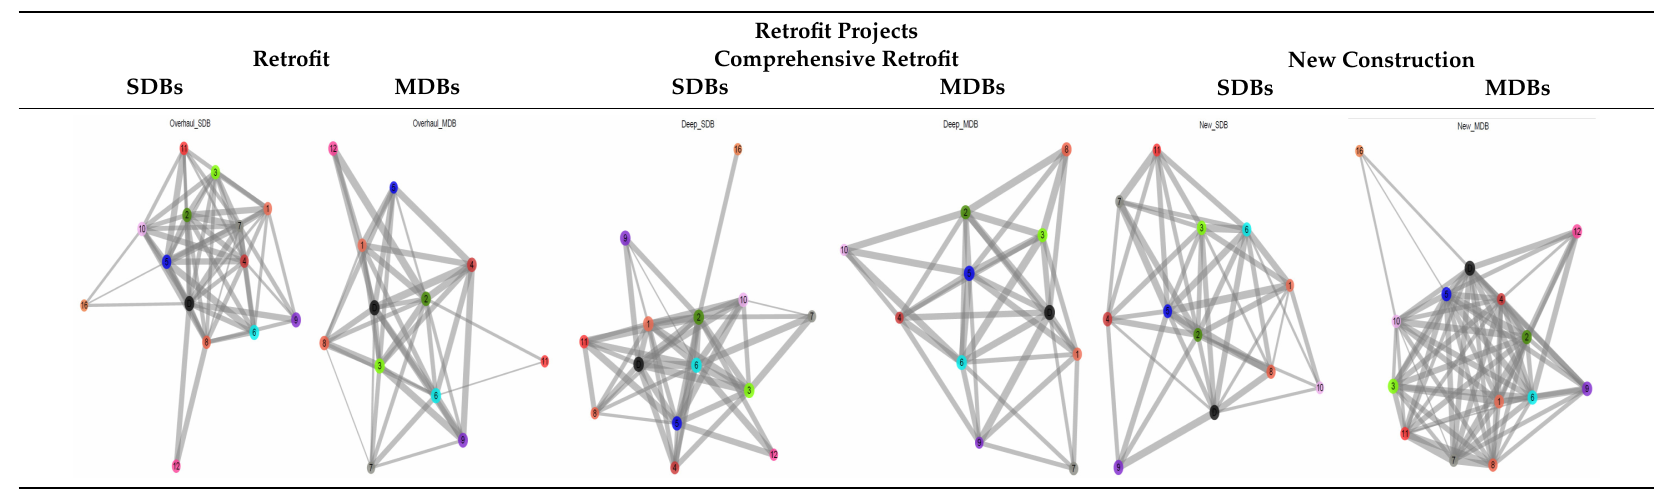
Table 9. Stakeholder level of power and interaction in the technology selection, classified according to building typologies and project types in Belgium (BE).